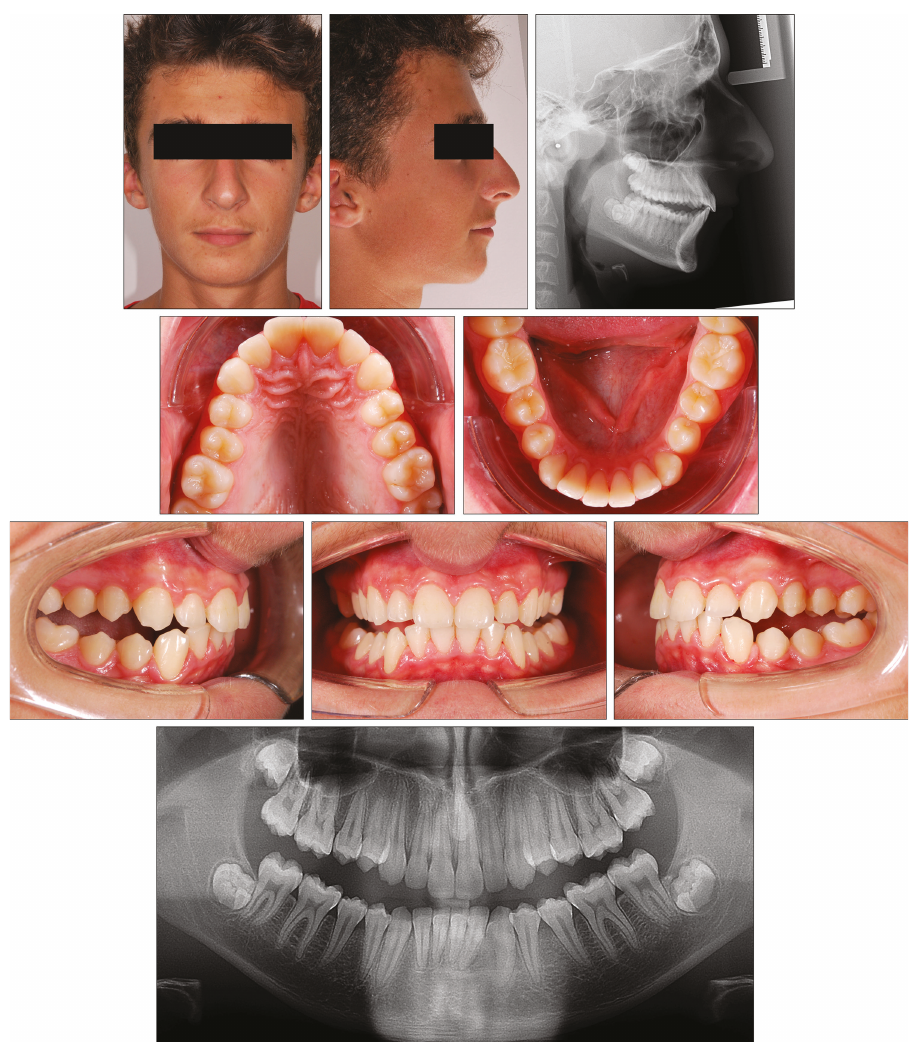
Figure 4: Case 1. Patient after 14 months of functional treatment with Twin-Block when he was 13 years and 10 months